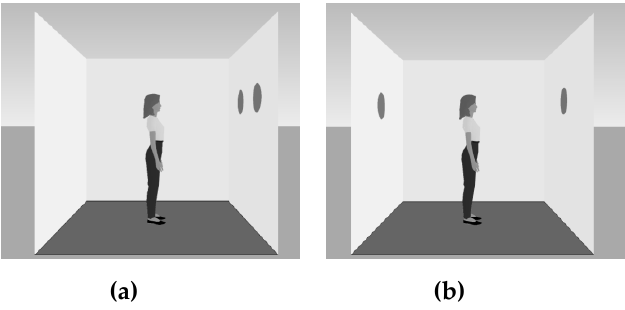
Figure 2. An example of consistent ( a ) and inconsistent ( b ) trials in the dot perspective task.